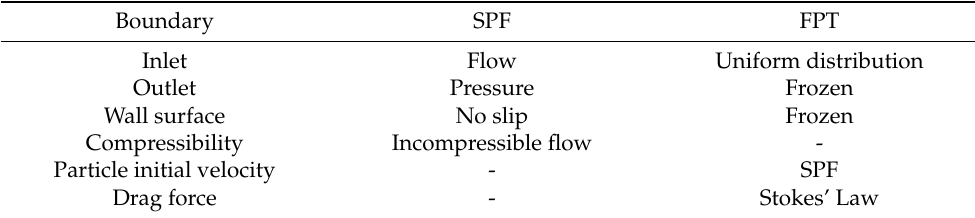
Table 1. Boundary condition